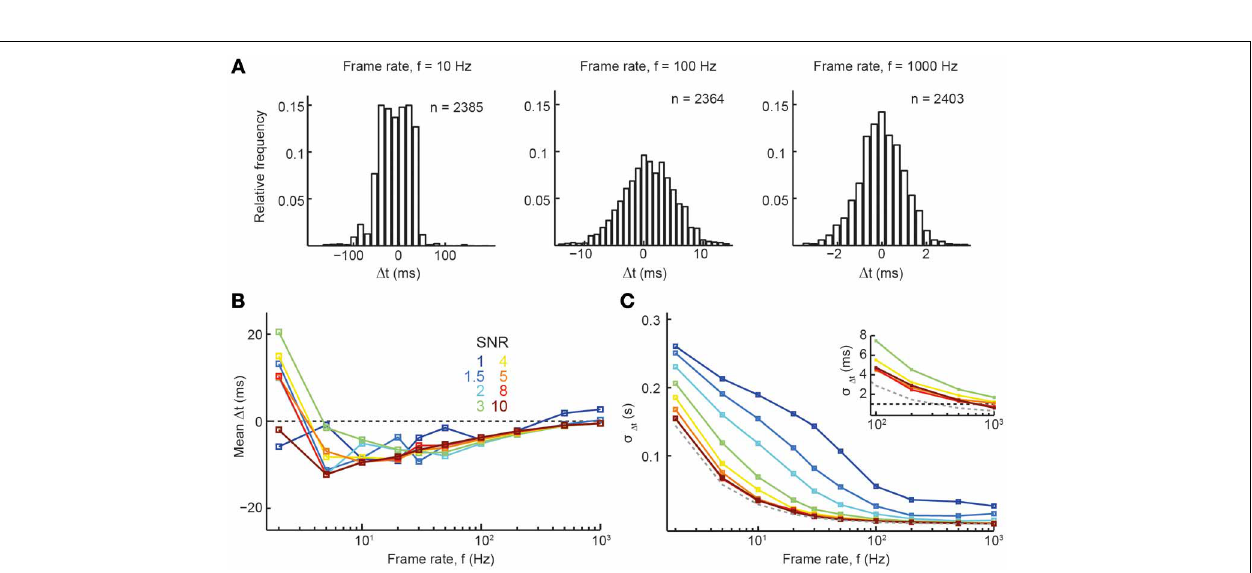
window for declaring correct AP detection: 100ms. (D) Dependence of error rate on mean saturation level during burst episodes with (gray) and without (white) taking saturation into account in the spike reconstruction with the peeling algorithm. Note the large increase in error rate at high saturation levels when a non-saturating, linear superposition of (cid:2) F / F transients is wrongly presumed. Analysis in (D) is based on simulations with frame rate ≥ 50Hz and SNR = 3 and 10. All simulated (cid:2) F / F traces were generated using the model of calcium dynamics including indicator saturation. All panels show mean ± SD.